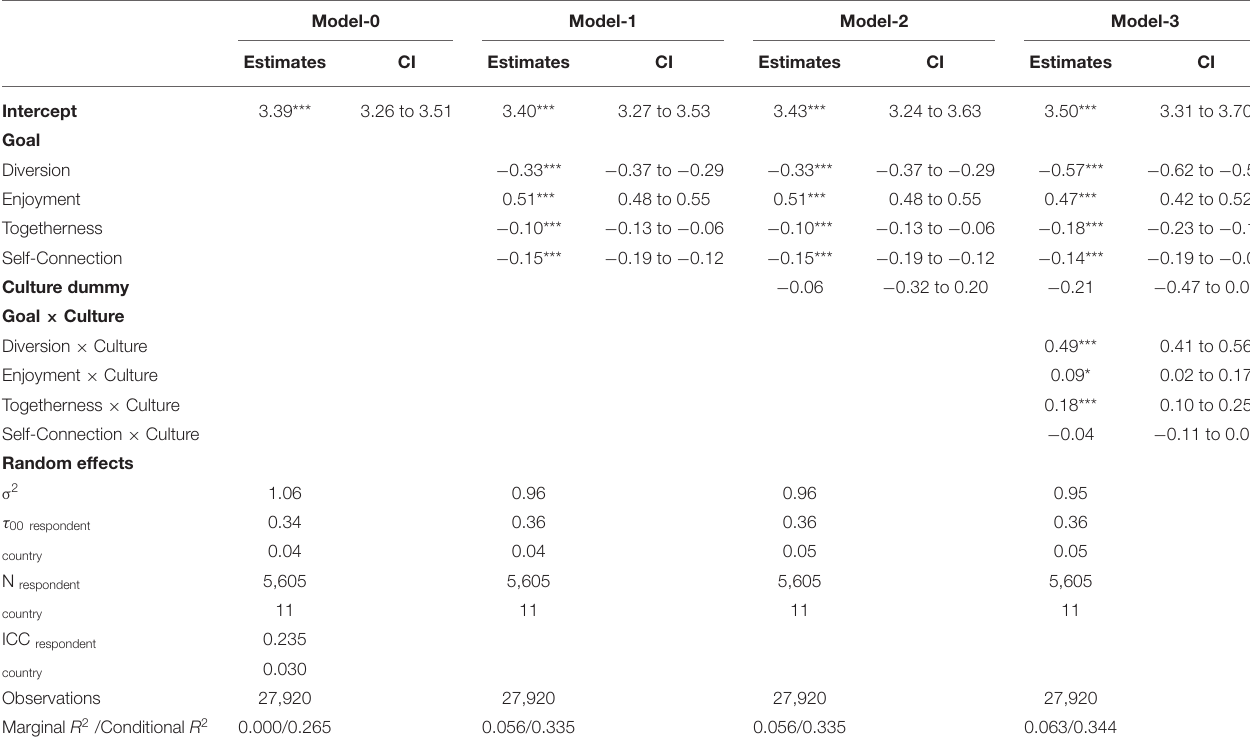
TABLE 1 | Overview of main statistical outcomes of multilevel regression models testing the effect of Goals, Culture (collectivism vs. individualism) and their interaction on evaluated importance.